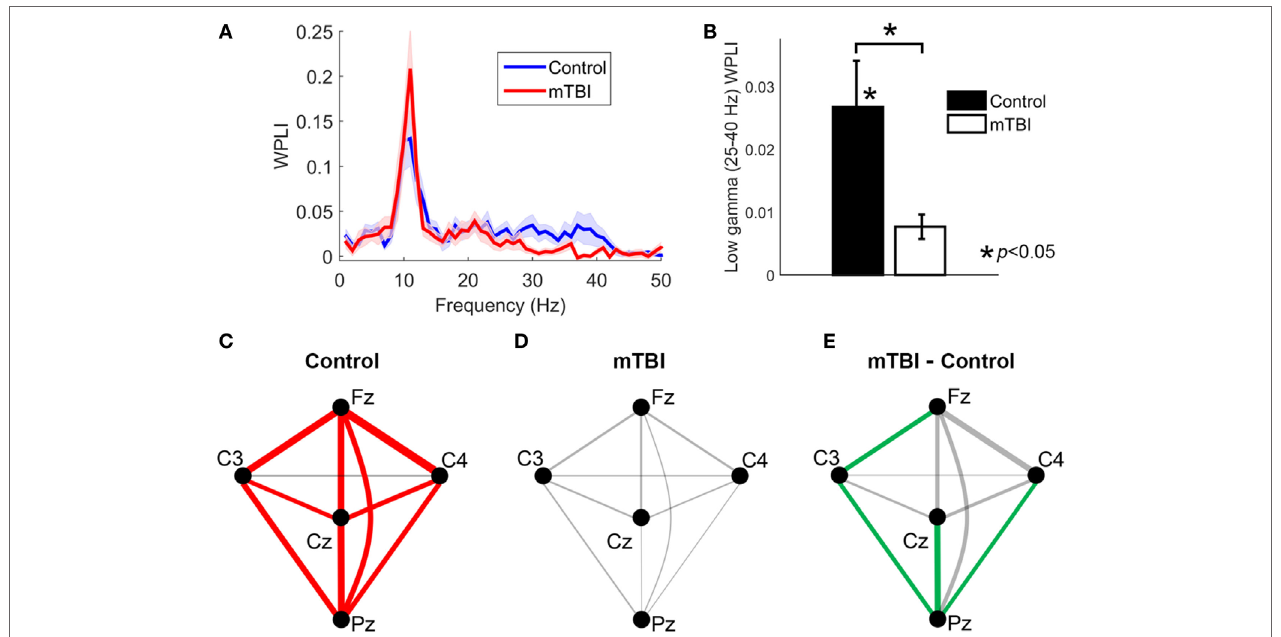
FigUre 1 | The analysis of weighted phase lag index (WPLI) for control and mild traumatic brain injury (mTBI) groups. (a) The WPLI spectra averaged across all electrode pairs. Shaded areas indicate the standard error of mean across participants at each frequency. (B) A bar plot comparing the mean value of WPLI spectra within low-gamma frequency (25–40 Hz) between control and mTBI groups averaged over all electrode pairs. (c,D) Low-gamma phase synchrony (measured by WPLI) for different electrode pairs for the control and mTBI groups, respectively. Line thickness is proportional to synchronization strength. Significant connections ( p < 0.05) are indicated by red lines. (e) The difference of low-gamma phase synchrony between mTBI and control groups for different electrode pairs. The electrode pairs with significant smaller low-gamma phase synchrony in mTBI group compared to control group ( p < 0.05) are indicated by green